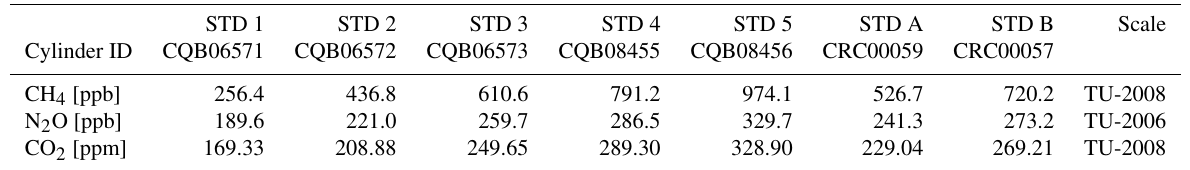
Table 2. Standard gases.